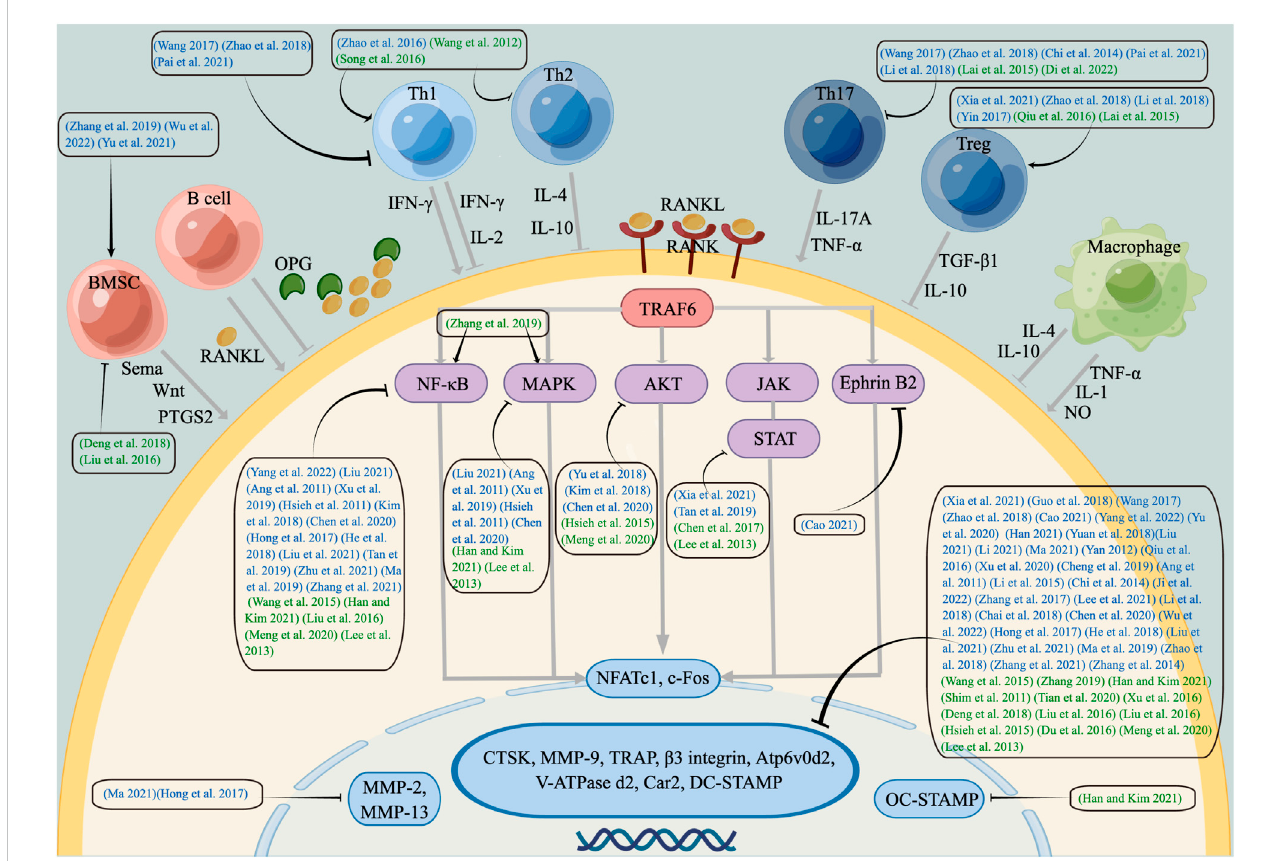
FIGURE 2 Schematic diagram of immunoregulation mechanisms of kidney-tonifying herbs on inhibiting osteoclastogenesis. Kidney-tonifying herbs inhibit Th1, Th2, Th17, BMSC and related cytokines and activate Th1, Treg, BMSC and related cytokines to suppress the RANKL/RANK, NF- κ B, MAPK, AKT, JAK/STAT signallingpathways,transcriptionfactorsNFATc1,c-Fos,andOCgenes,whichplayaroleinOCformationandfunction.Bluerepresentstonifyingkidney-yang botanicaldrugs, while green representsnourishingkidney-yinbotanicaldrugs. Arrows ( ↓ )indicate positiveimpact,while inverted Ts( ⊥ )indicatenegative